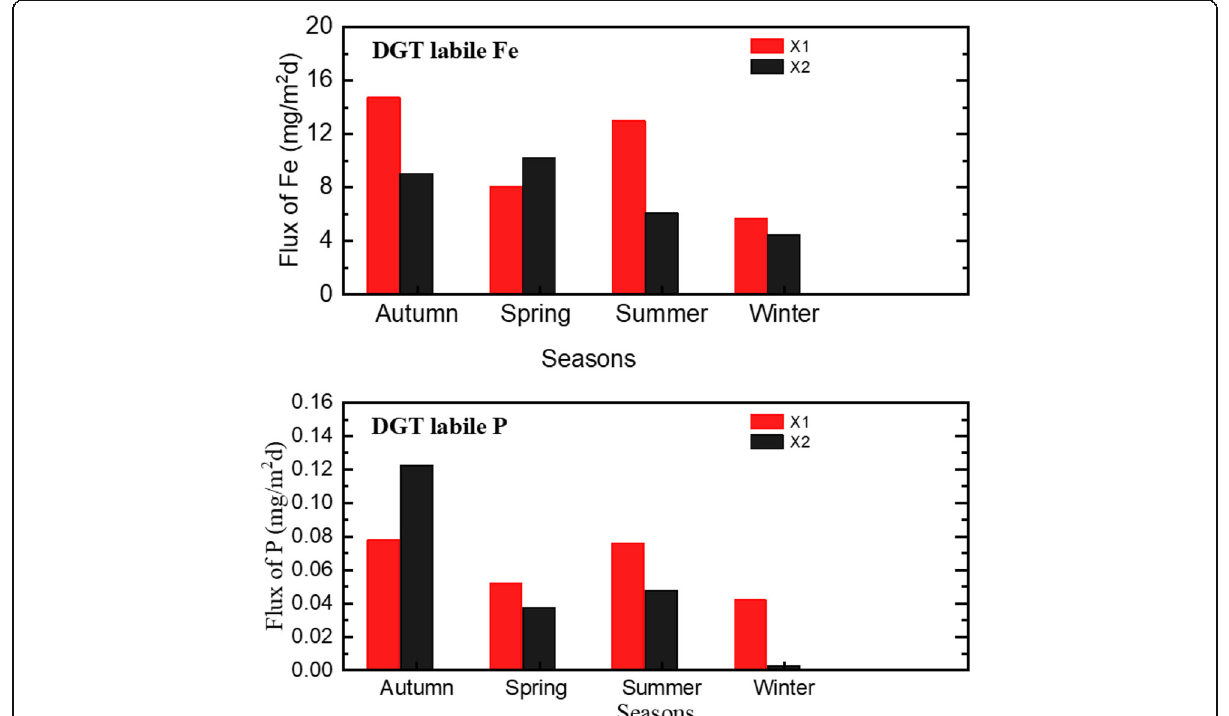
Fig. 5 The diffusive fluxes of Fe and P at the sediment-water interface in X1 of Tianbao Reservoir